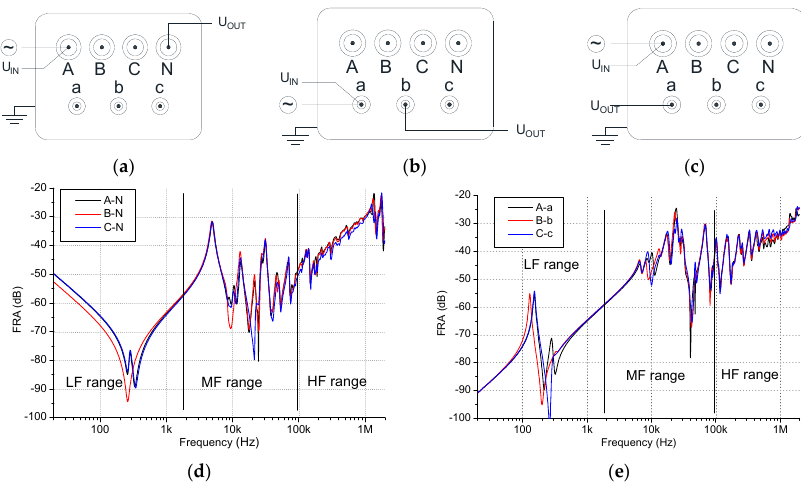
Figure 1. Schematic presentation of test setups and corresponding examples of results for Y-connected winding: ( a , d ) end-to-end open measurement; ( c , e ) interwinding capacitive measurement; ( b ) schematic presentation of end-to-end open test setup for delta connected